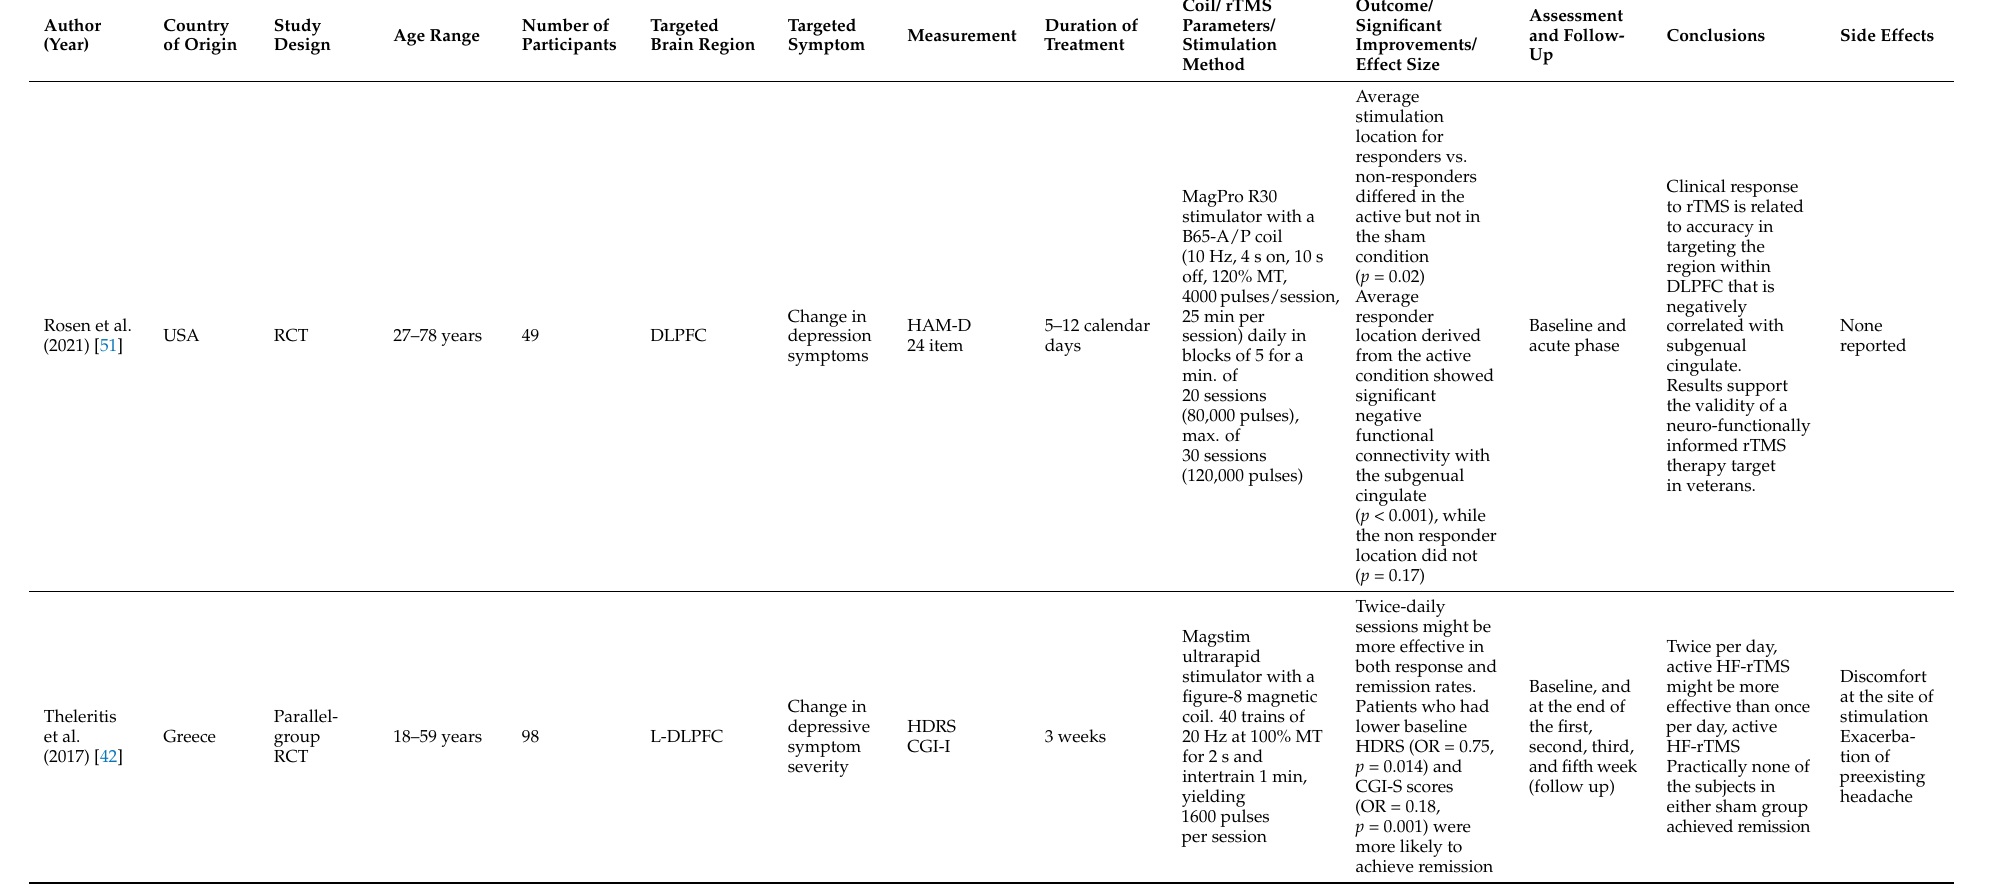
stimulator with a figure-8 magnetic coil. 40 trains of 20 Hz at 100% MT for 2 s and intertrain 1